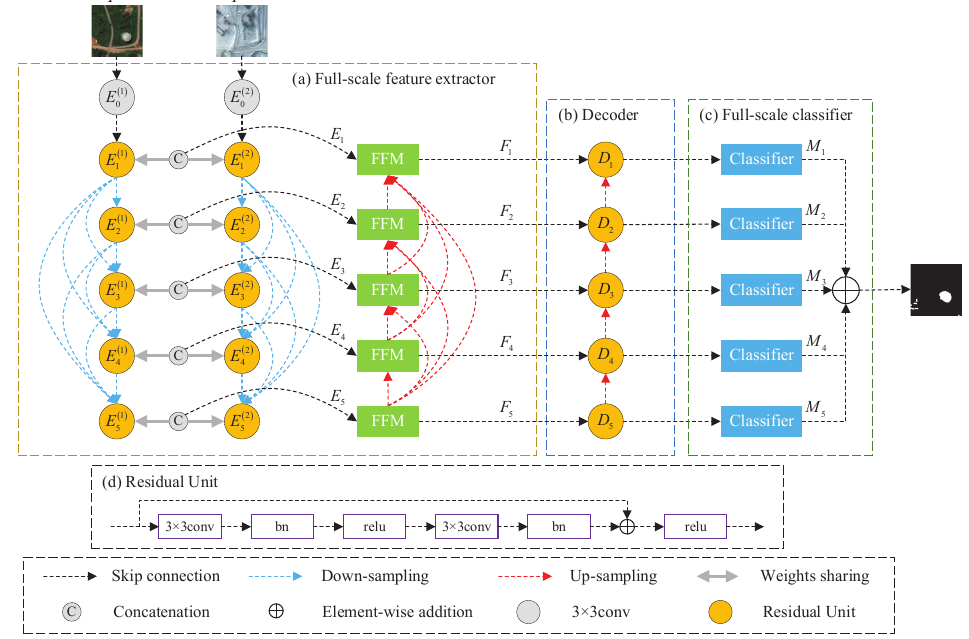
Figure 2. The framework of F3SNet. ( a ) Full-scale feature extractor (FFE) contains a top-down branch and a bottom-up branch. ( b ) The decoder receives the feature maps from the FFE and generates multi- scale feature maps. ( c ) The full-scale classifier generates and aggregates the multi-scale prediction maps. ( d ) Residual Unit. Note that the circle indicates the node with parameters, and the letter inside it indicates its output feature